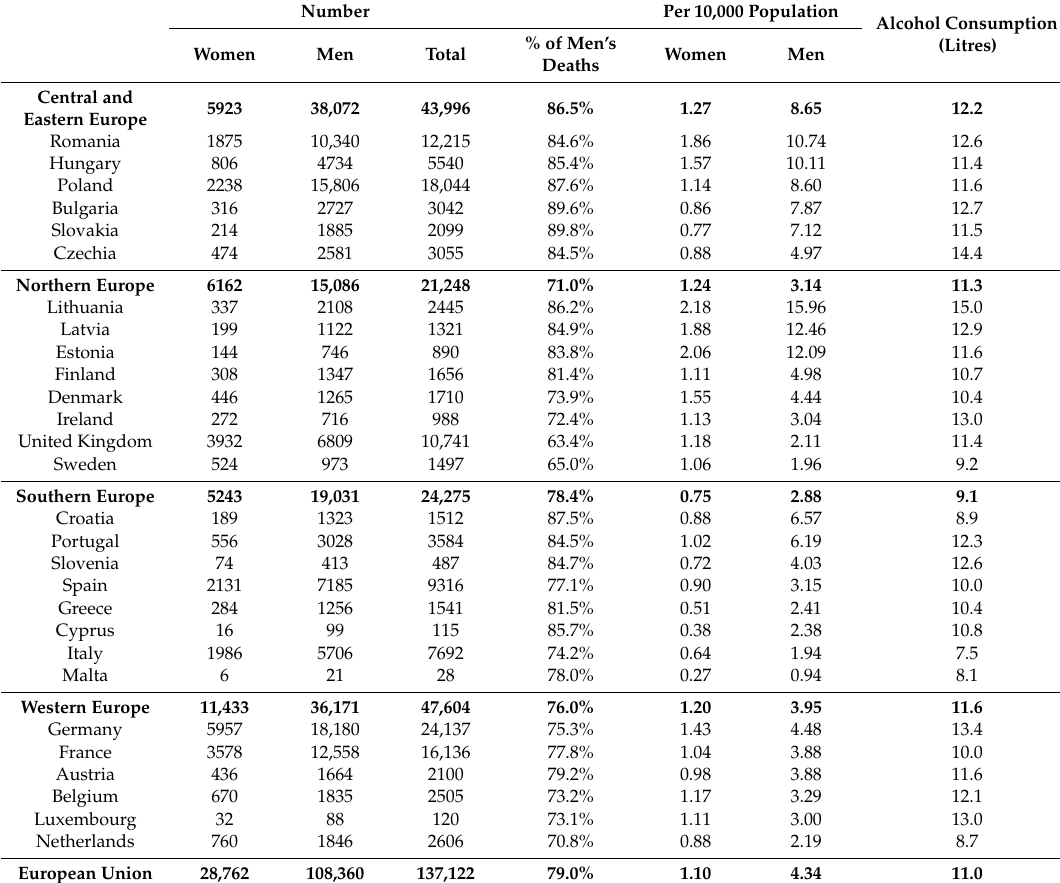
Table1. Estimatednumberandincidenceofalcohol-attributabledeathsatworkingageandconsumption of alcohol in 28 European Union countries,